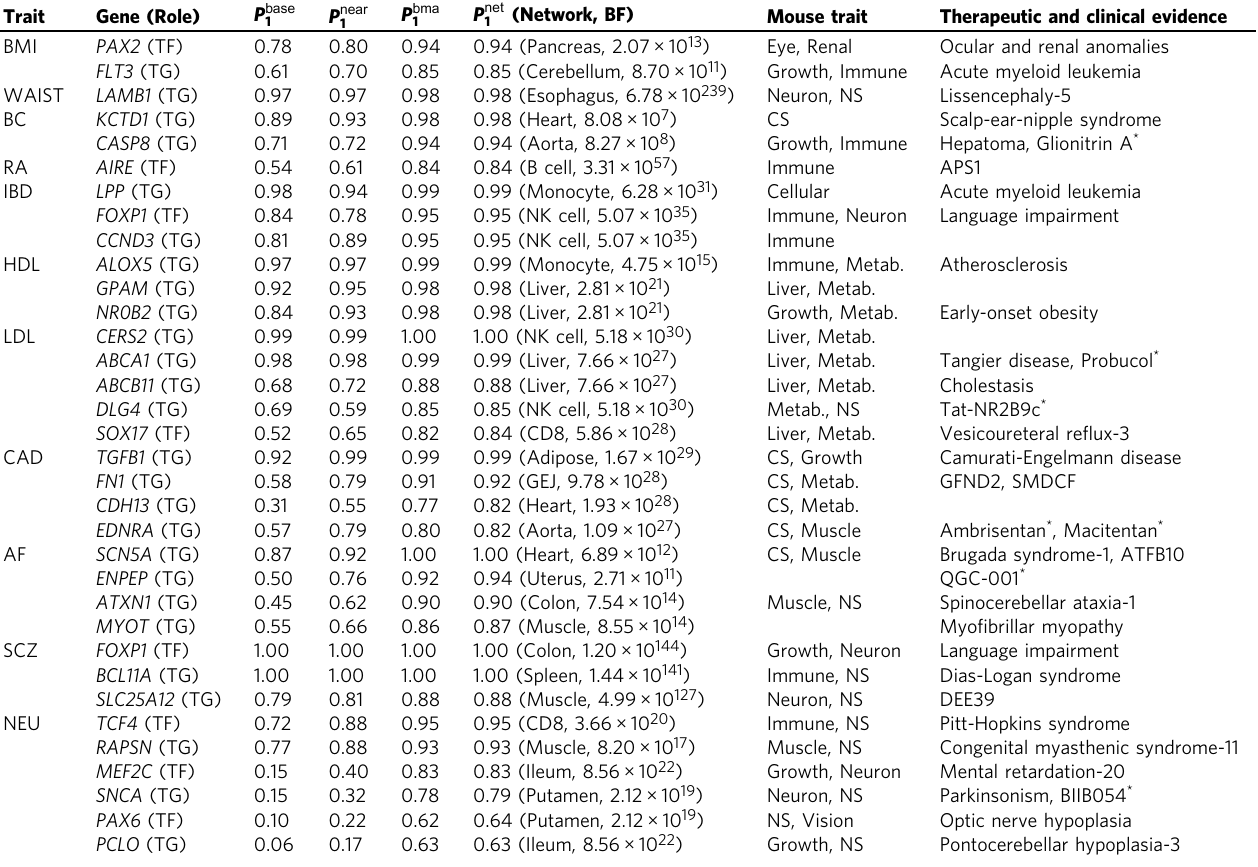
The “ mouse trait ” column is based on the Mouse Genome Informatics 47 . The “ therapeutic/clinical evidence ” column is based on the Online Mendelian Inheritance in Man 50 and Therapeutic Target Database 53 . Drugs are identi fi ed with an asterisk ("* ” ). Trait abbreviations are de fi ned in Supplementary Table 1. GEJ: gastroesophageal junction. CS: cardiovascular system. DS: digestive/alimentary system. Metab.: metabolism. NS: nervous system. APS1: autoimmune polyendocrinopathy syndrome-1. GFND2: glomerulopathy with fi bronectin deposits-2. SMDCF: corner fracture type of spondylometaphyseal dysplasia. ATFB10: familial atrial fi brillation-10. DEE39: developmental and epileptic